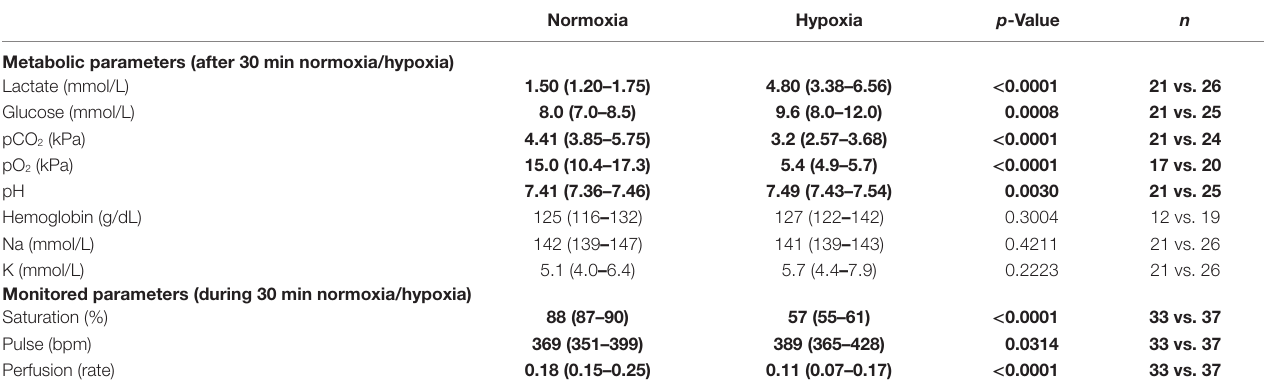
TaBle 2 | Post- and pre-operative monitoring